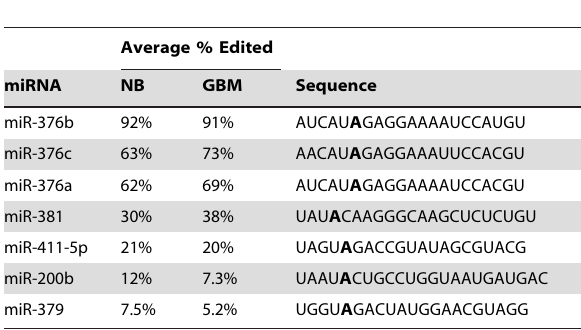
Table 1. A to G substitutions in miRNA seed